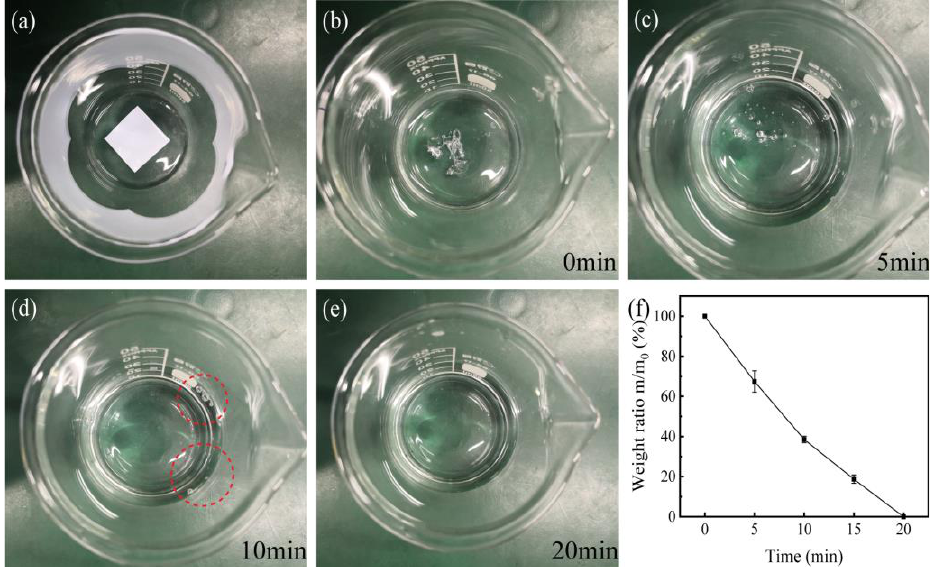
Figure 5. The triggered transiency of CPM: ( a ) Initial state without adding water; ( b ) the moment water was added; ( c ) dissolution status after 5 min; ( d ) dissolution status after 10 min, the bubbles left were marked by red circles; ( e ) dissolution status after 20 min; ( f ) the weight ratio as a function of dissolution time.